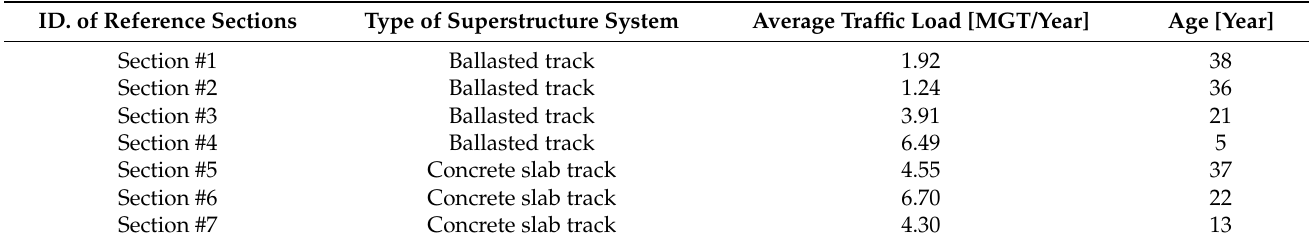
Table 2. Characteristics of examined reference